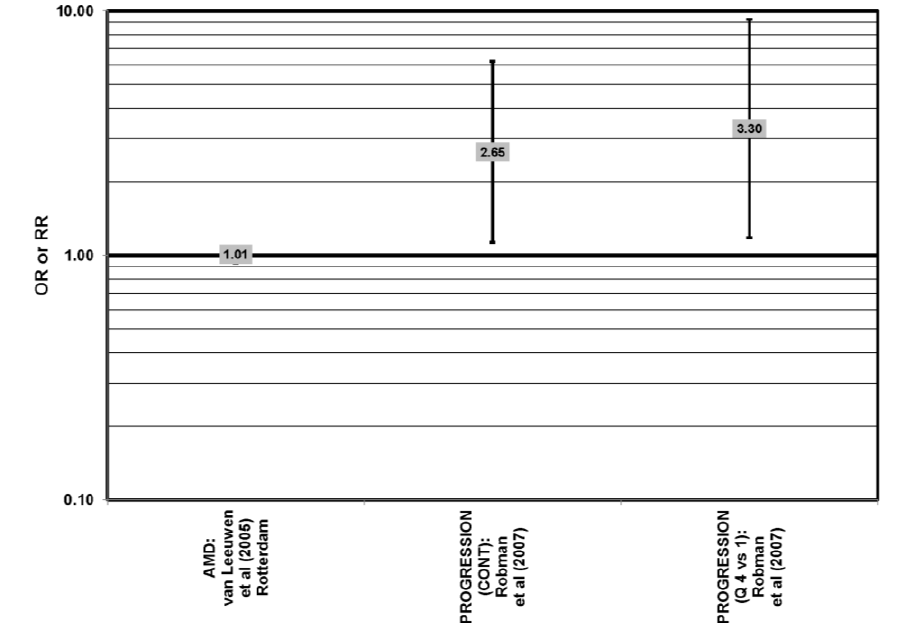
Figure 30. AMD odds or risk ratio; high vs. low intake of lutein and zeaxanthin: prospective studies.